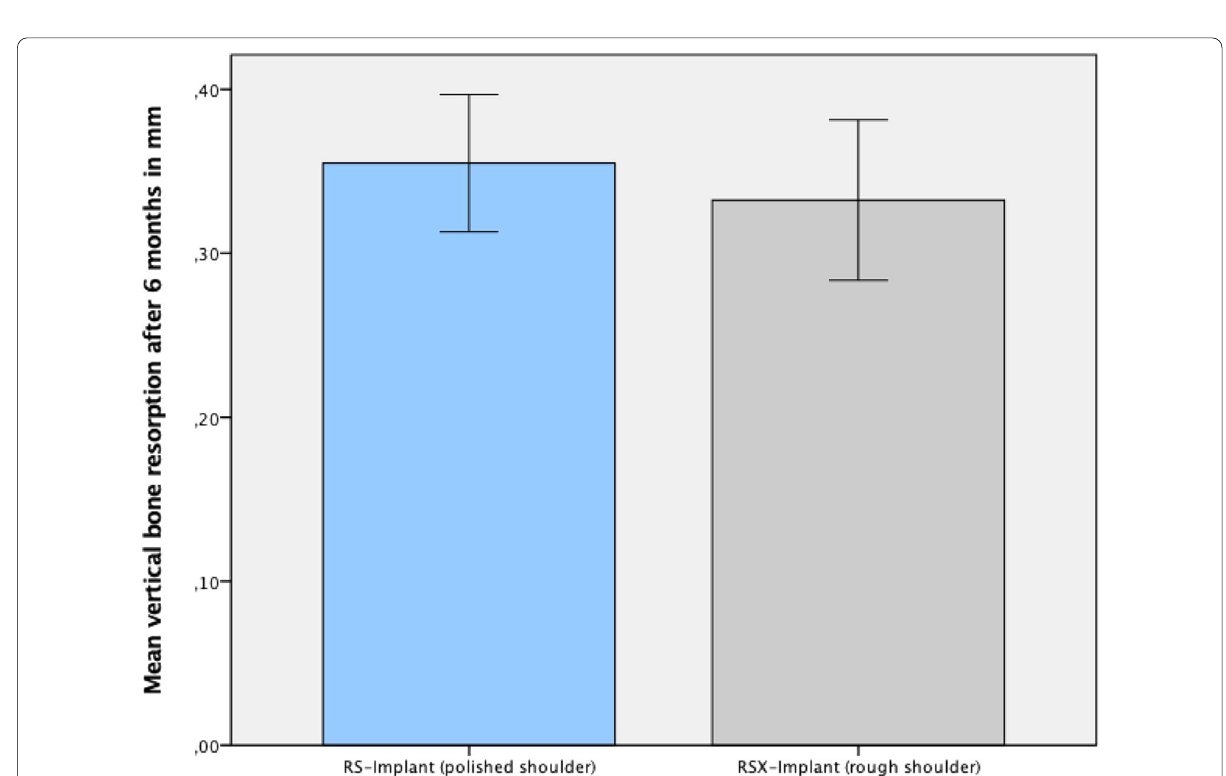
Fig. 5 Average bone level changes in mm within 6 months left (polished shoulder) and RSX-line implant (rough shoulder)